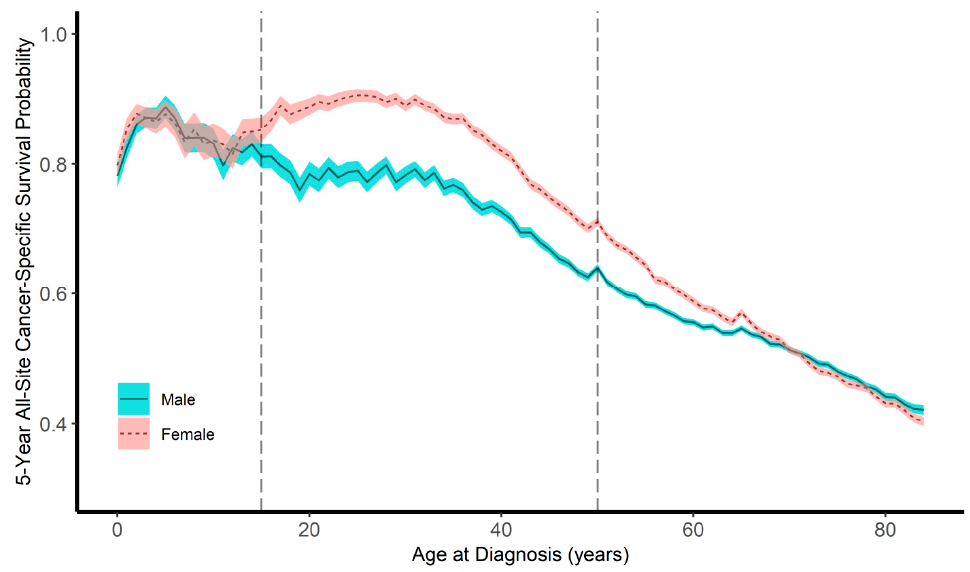
Figure 3. Line plot of the 5-year all-site cancer-specific survival proportion at every age (up to 84 years). The all-site hazard of cancer-specific deaths was 5% higher in boys than in girls (HR, 1.05; 95% CI, 1.01 to 1.10; p = 0.03; Figure 4). Boys had a statistically significant survival advantage for non-Hodgkin lymphoma (HR, 0.62; 95% CI, 0.49 to 0.80; p < 0.001) but a statistically significant survival disadvantage for acute lymphocytic leukemia (HR, 1.16; 95% CI, 1.03 to 1.30; p = 0.01) and chronic myeloid leukemia (HR, 1.99; 95% CI, 1.16 to 3.42; p = 0.01).